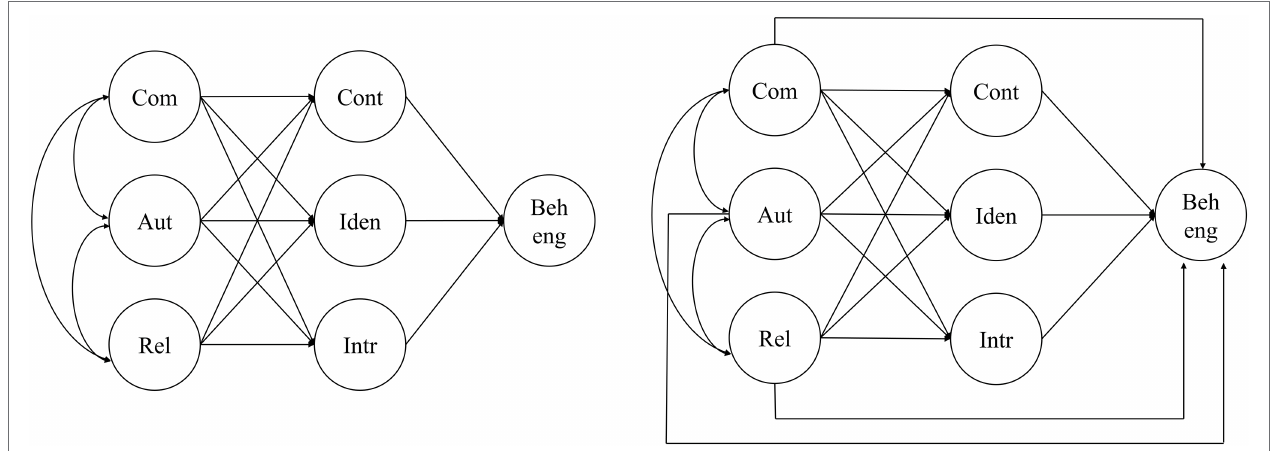
FIGURE 1 | Path diagrams describing the structural relation between the latent variables of the original model (to the left) and the alternative model (to the right). The measurement model, including all observed variables, is excluded in this diagram. Com, perceived competence; Aut, perceived autonomy; Rel, perceived relatedness; Cont, controlled motivation; Iden, identified regulation; Intr, intrinsic regulation; and Beh eng, behavioral